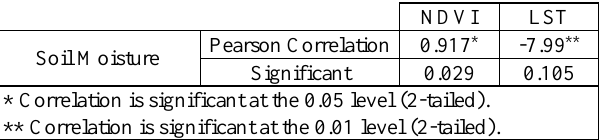
Table 3. Correlation between soil moisture content and LST and NDVI indices.